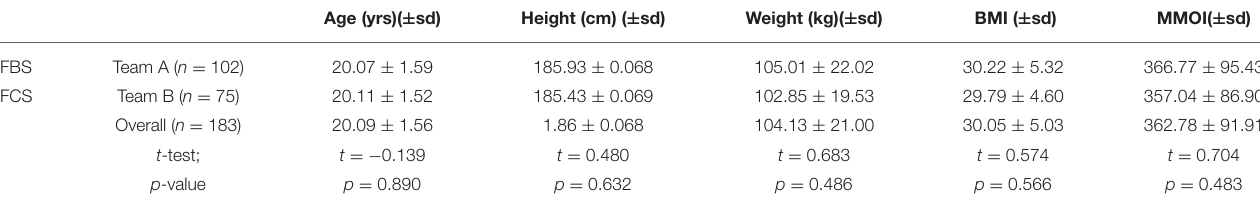
TABLE 1 | Demographic data for each of the football teams in the cohort.